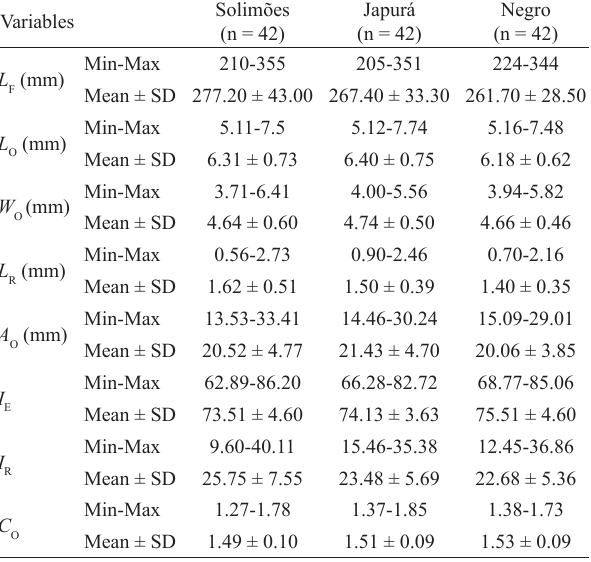
notch and the cauda lesser